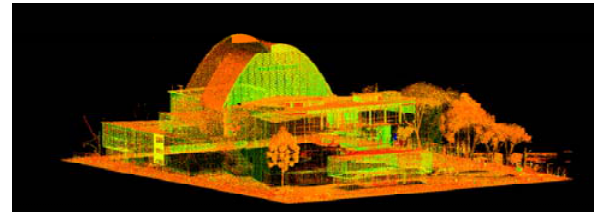
Figure 1. Registered high density Point Clouds – Exterior Façades